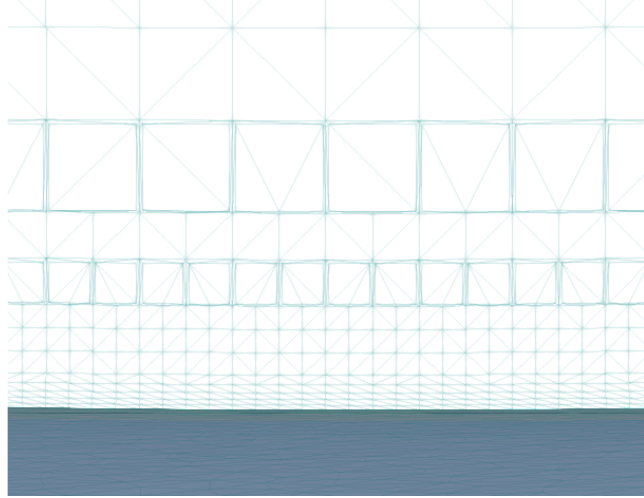
Figure 9. Detail of the generated mesh.